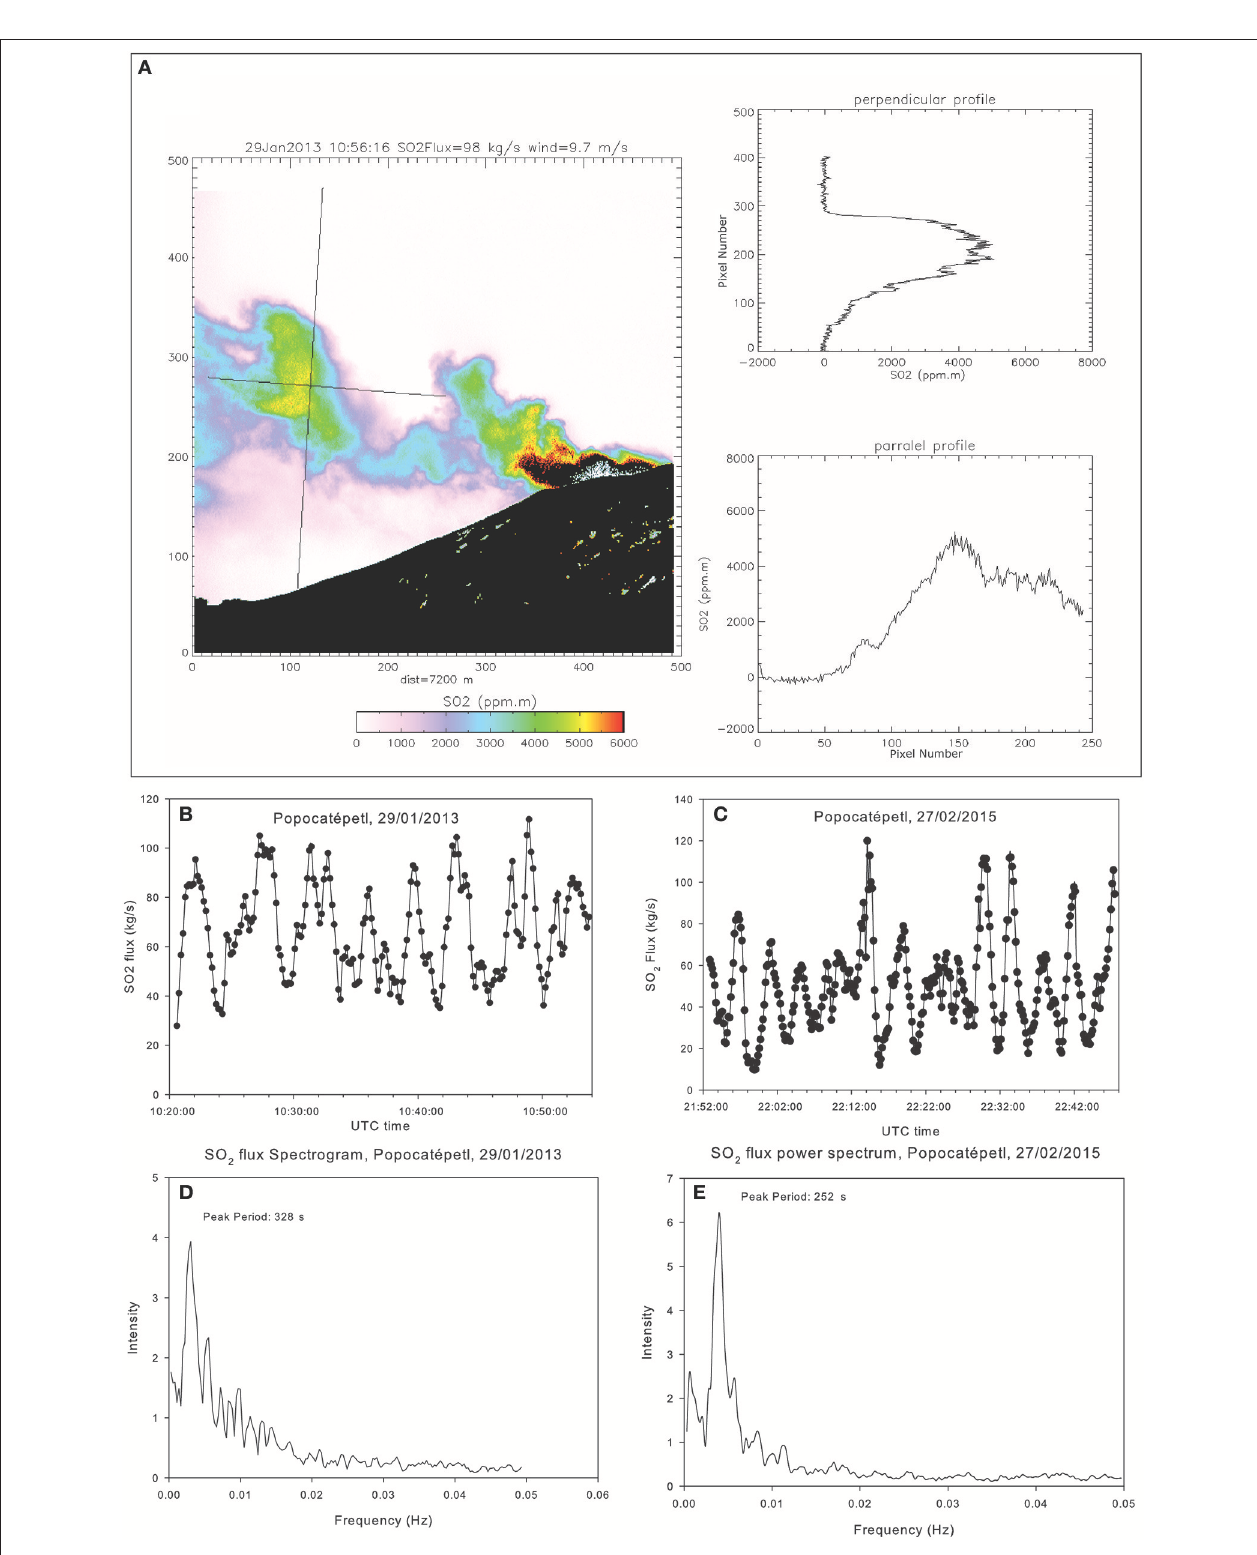
FIGURE 3 | Pulsating passive degassing at Popocatépetl. (A) Aspect of the puffs on an SO 2 distribution map taken from Paso de Cortés (location P5 in Figure 1 , 7.5km South of the crater). Two time series of SO 2 flux during passive degassing measured on 29/01/2013 (B) and 27/02/2015 (C) showing the quasi-periodic puffing behavior (D) and (E) discrete Fourier Transform spectra of the time series presented in Figures 3B,C , respectively highlighting the ∼ 300s periodicity.